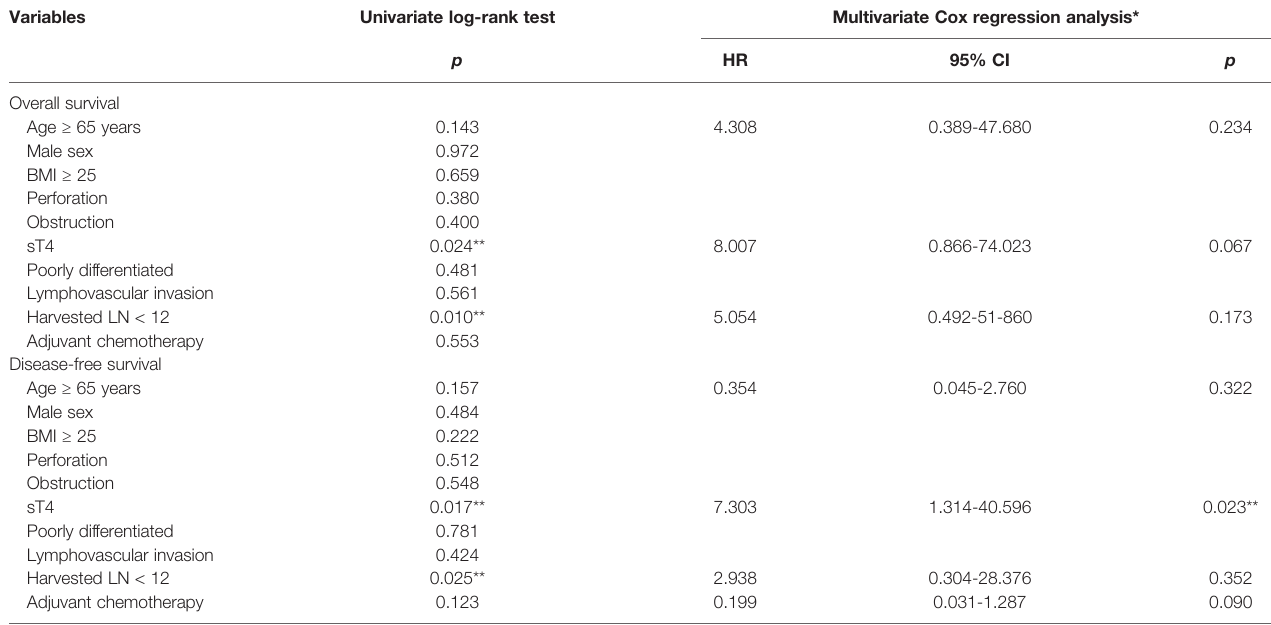
TABLE 4 | Univariate log-rank test and multivariate Cox proportional hazards model for survival. Variables